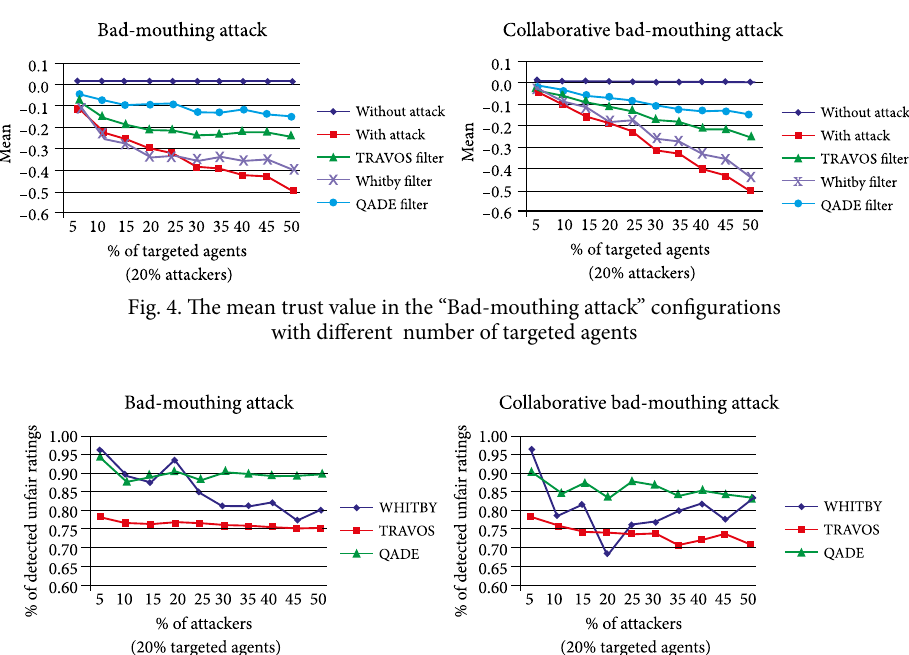
Fig. 5. The percentage of detected unfair ratings in the “Bad-mouthing attack” configurations with different number of